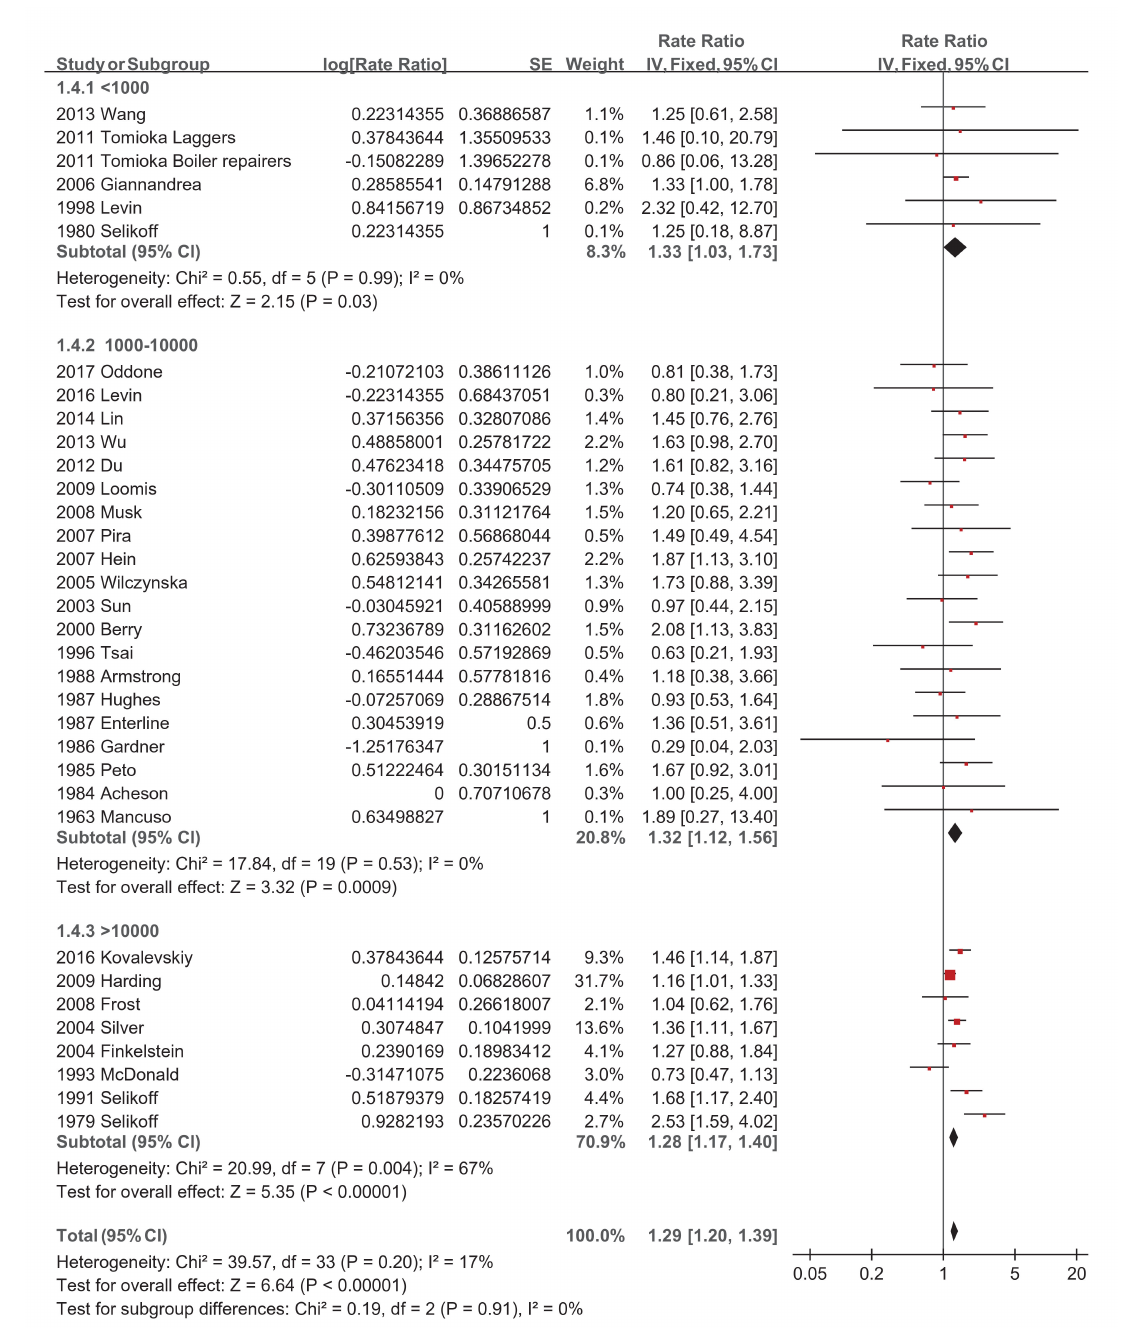
Figure 6. Subgroup analysis of SMRs of esophageal cancer based on sample